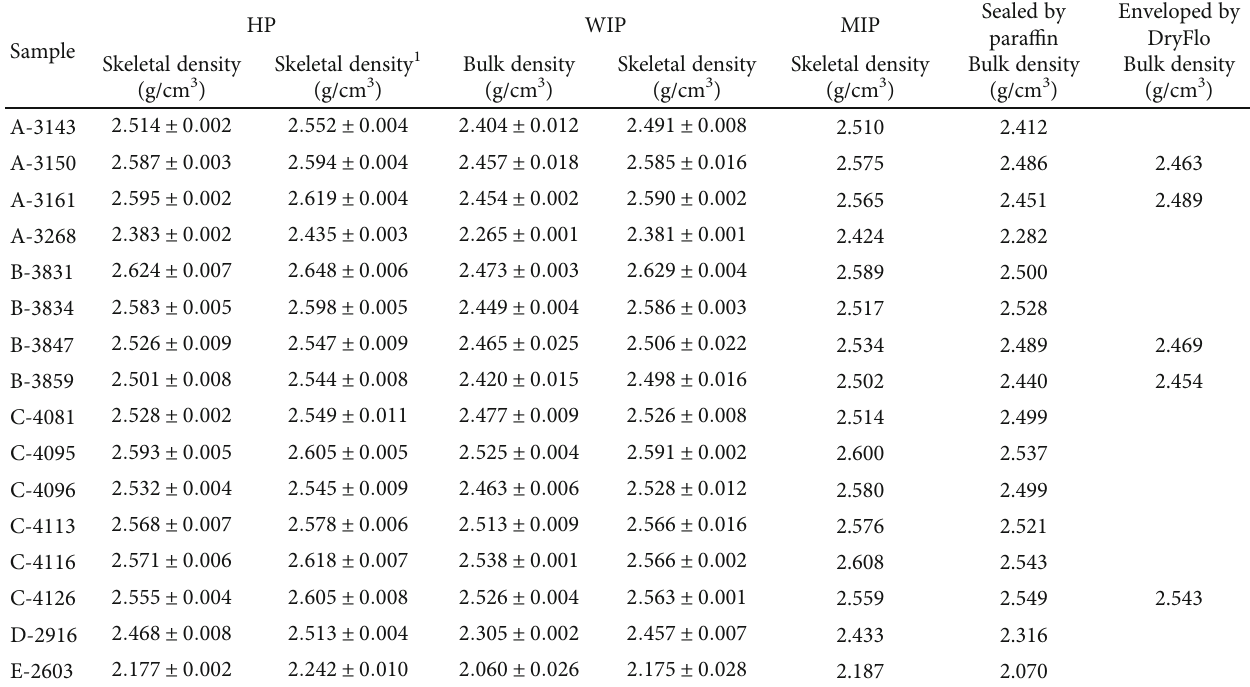
Table 2: Results of bulk and skeletal densities from various methods.